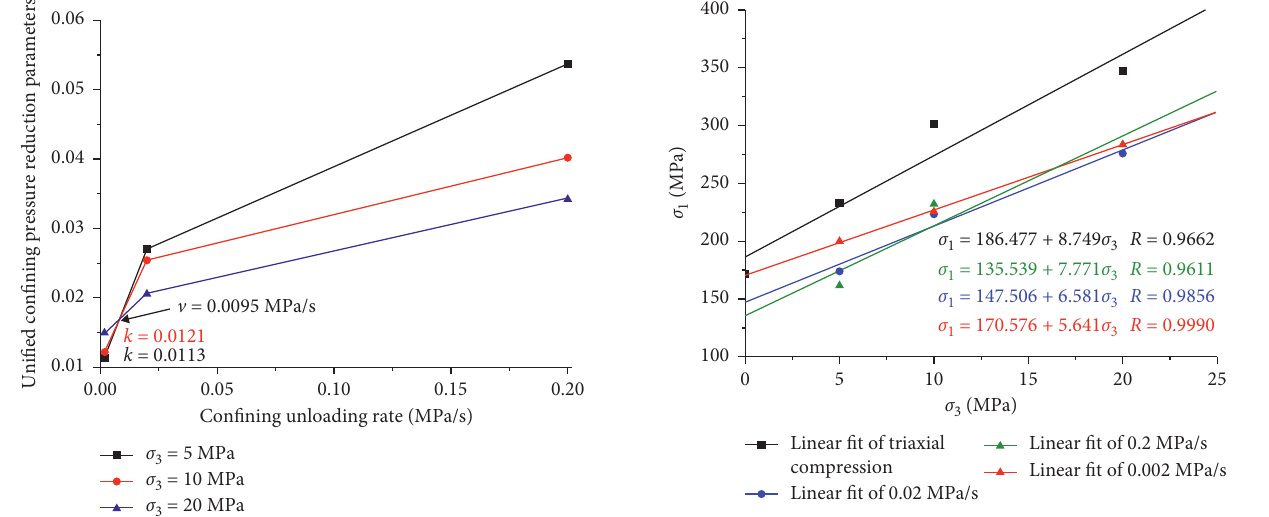
Figure 8: Unified confining pressure reduction parameters under different confining pressure unloading